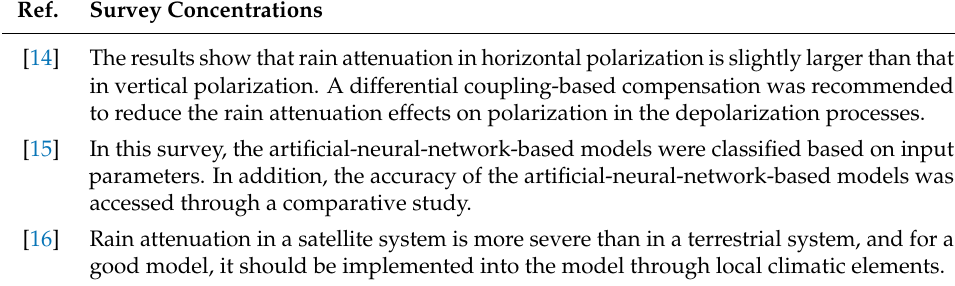
Table 1. Rain attenuation survey